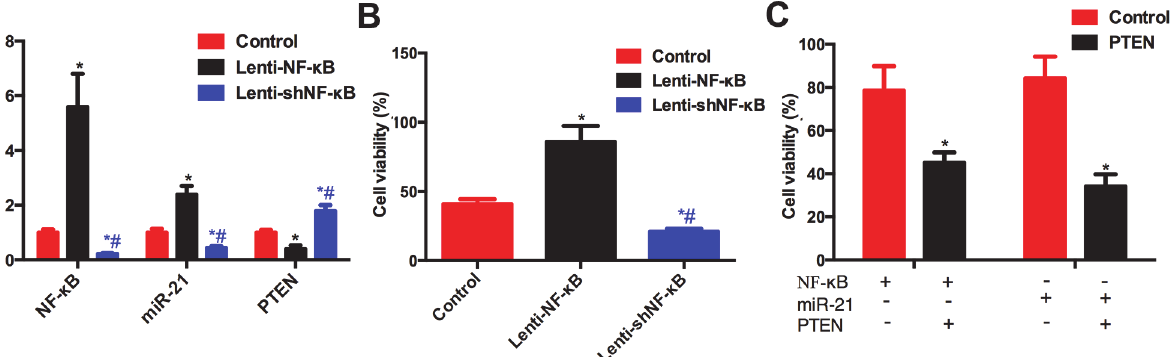
Fig 5. NF- κ B/miR-21/PTEN pathway modulated cell viability. (A) mRNA expressions of NF- κ B, miR-21 and PTEN in the cells transduced with Lenti- control, Lenti-NF- κ B and Lenti-shNF- κ B. The miR-21 level was significantly increased while the PTEN was decreased in the cells transduced with Lenti-NF- κ B compared with control vector. The miR-21 level was significantly decreased while the PTEN was decreased in the cells transduced with Lenti-NF- κ B. (B) Cell viability was increased by Lenti-NF- κ B while decreased by Lenti-shNF- κ B. (C) Overexpression of PTEN restored the sensitivity of A549 cells to cisplatin treatment compared with overexpression of NF- κ B or miR-21. * compared with control group, # compared with Lenti-NF- κ B group. P < 0.05 as significant